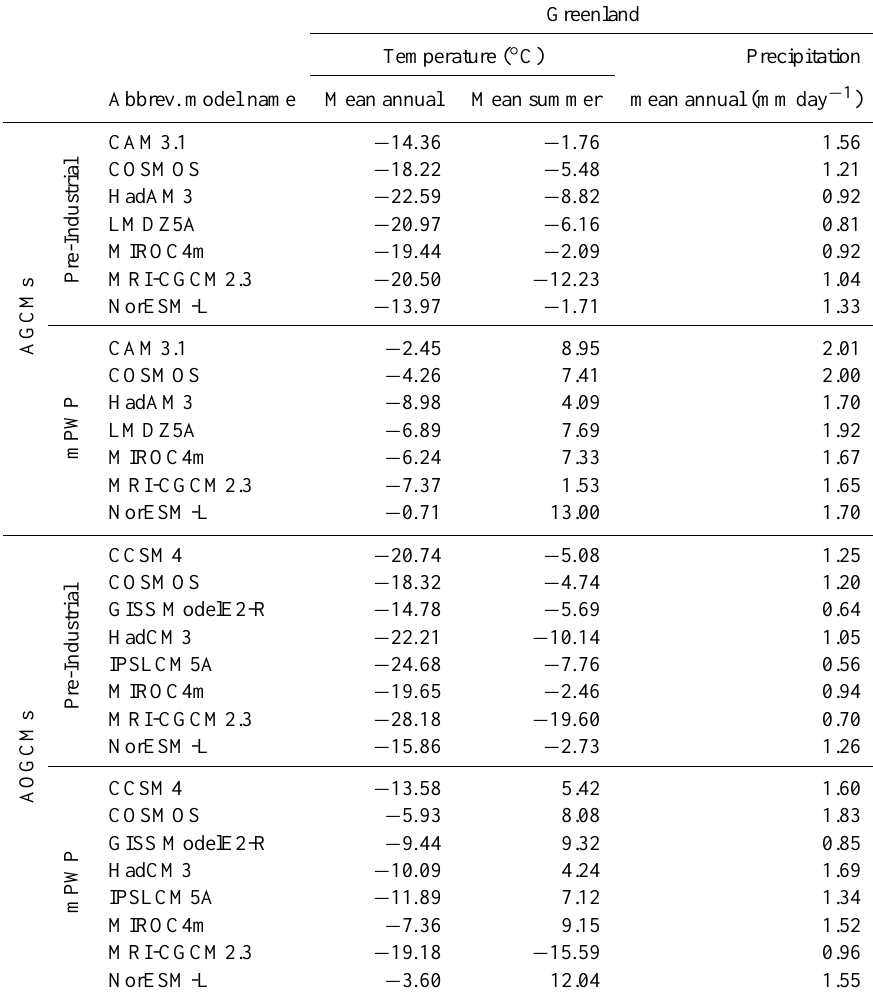
Table 3. Mean annual and summer temperature and mean annual precipitation values over the Greenland region for the PlioMIP climate models for the pre-industrial control experiments and the mPWP simulations. The climatological values have been calculated over the entire Greenland land mass as defined by the individual land–sea masks prescribed in the climate models. No ocean temperatures/precipitation values have been